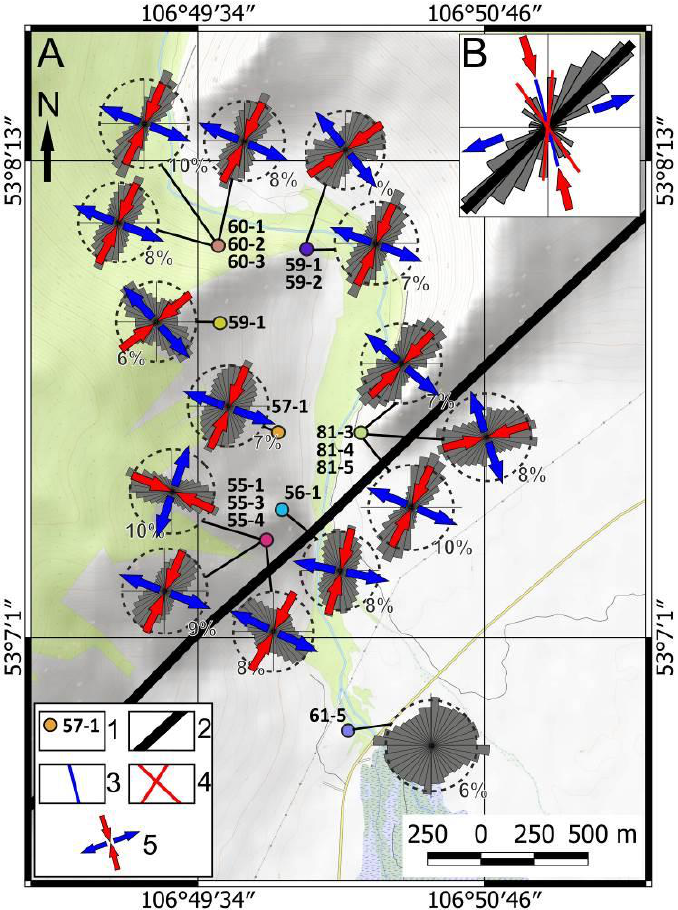
Figure 13. Scheme for interpreting the orientations of the principal axes of stress fields. ( A ) Interpretation of orientations of the main axes of the stress field performed for single rock samples based on the analysis of rose diagrams of microfractures, taking into account the fact that most studied microstructures are cracks of mode I; ( B ) interpretation of the orientations of principal axes of the modern stress field, performed via the analysis of lineaments in the area of the Sarma River [75,101,102]. 1 — sampling points and their numbers; 2 — Primorsky Fault; 3 — cracks of mode I; 4 — pair cracks of mode II; 5 — orientation of the main axes of compression (red) and tension (blue).